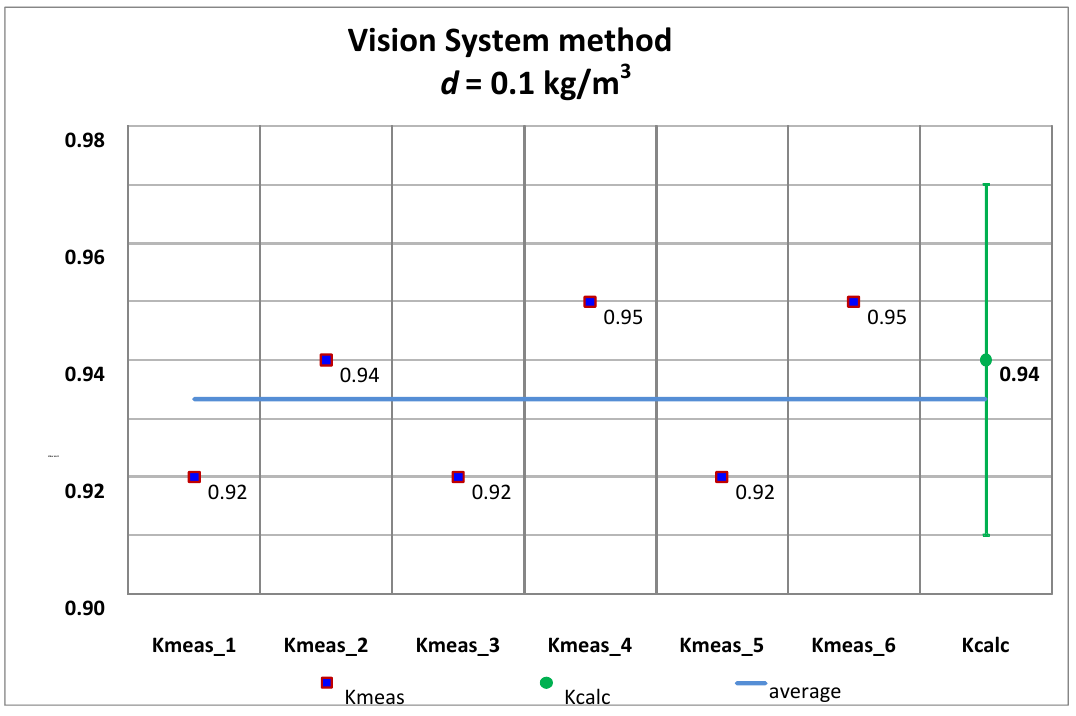
values. High accuracy hydrometer. Vision system alignment. Figure 21. K meas